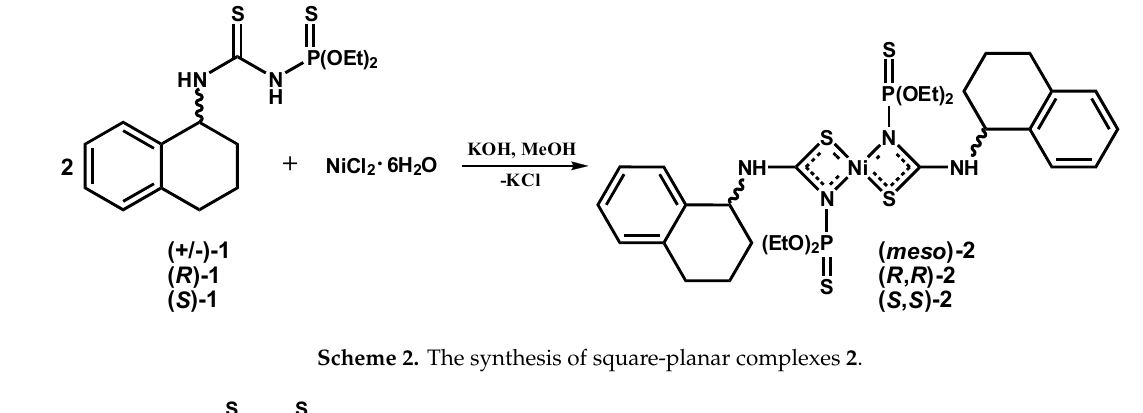
Scheme 1. The synthesis of N -thiophosphorylated thioureas 1 .